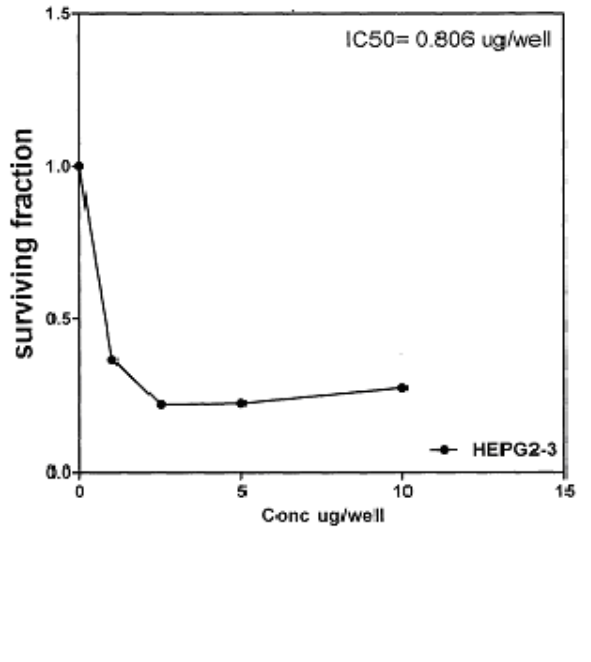
Figure 8. Effect of conc. of 14a on HEPG2